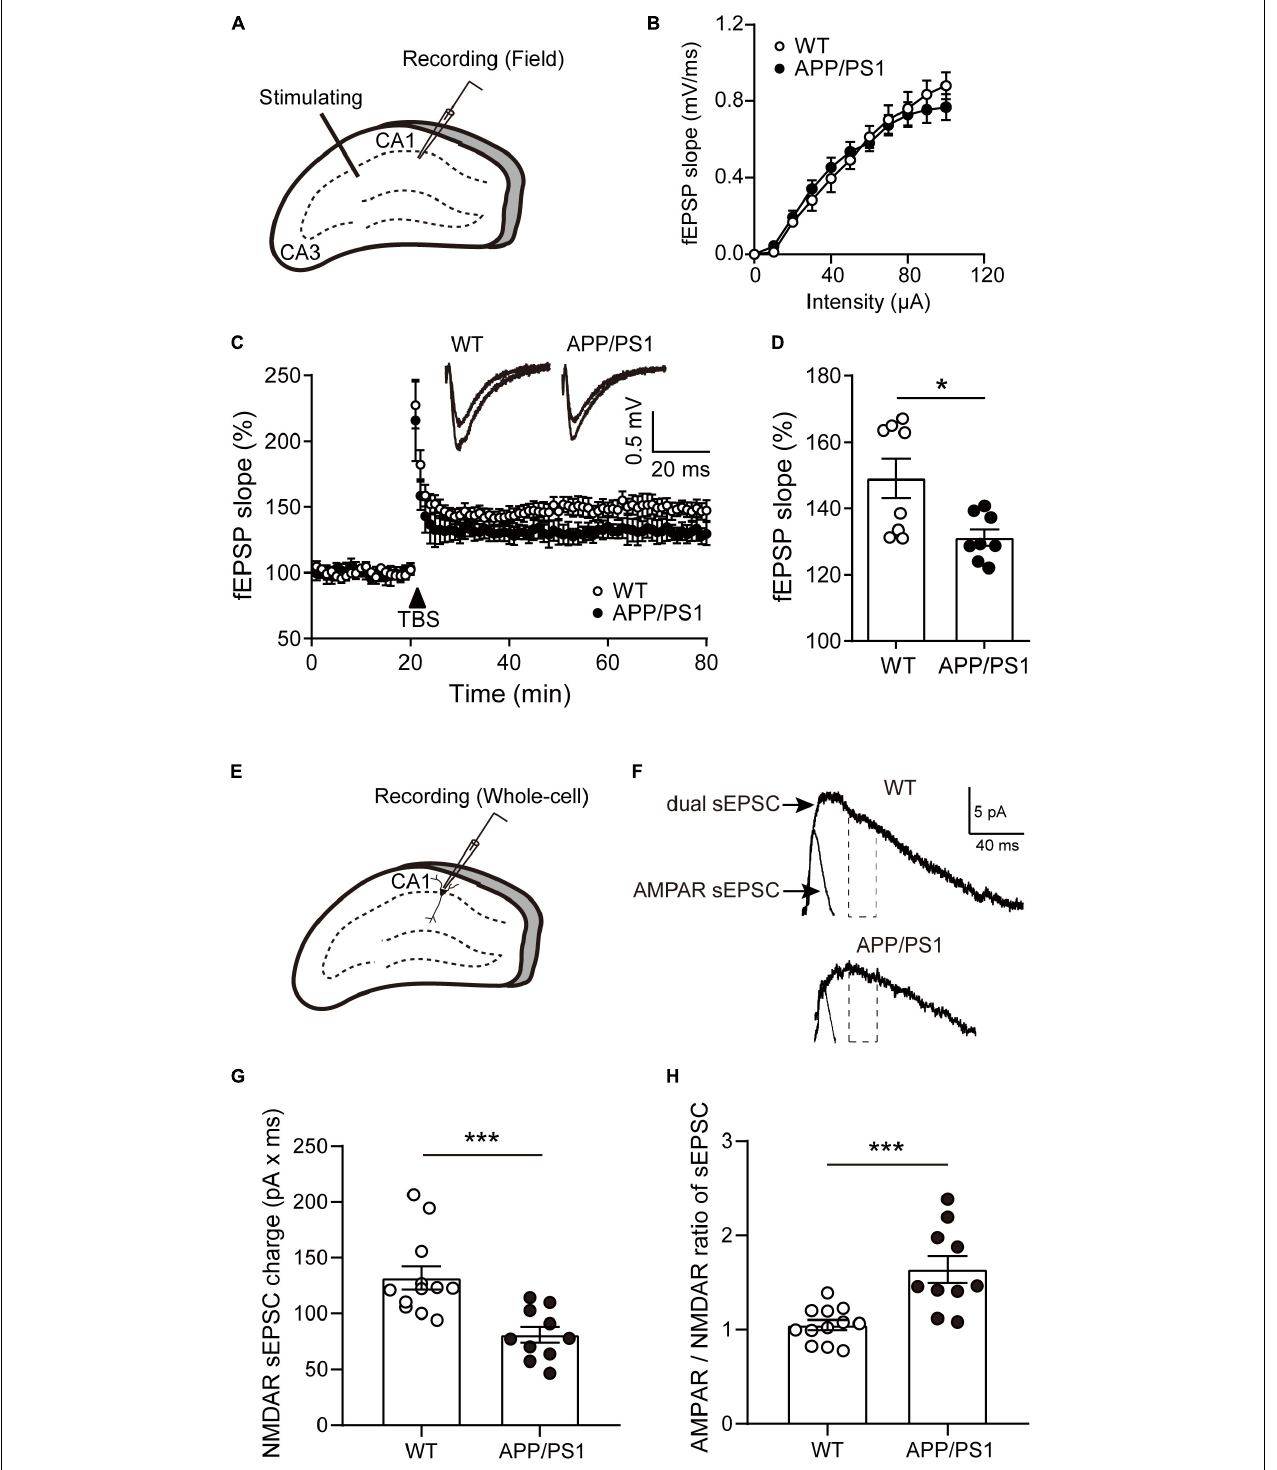
FIGURE 4 | The LTP and NMDAR sEPSCs of pyramidal neurons in the CA1 of 8-month-old APP/PS1 mice. (A) Schematic diagram of fEPSP recording. (B) The input-output (I/O) curves in response to stimulus in the CA1 of WT and APP/PS1 mice. (C) Representative traces showing LTP in CA1 of WT and APP/PS1 mice. (D) Quantification of the last 15 min of fEPSP recordings ( n = 8 slices from 4 mice/group; * p < 0.05, unpaired t -test). (E) Schematic diagram of whole-cell recording. (F) The diagram showed typical average events from WT and APP/PS1 mice. NMDAR sEPSCs were estimated from the charge of the dual sEPSCs after